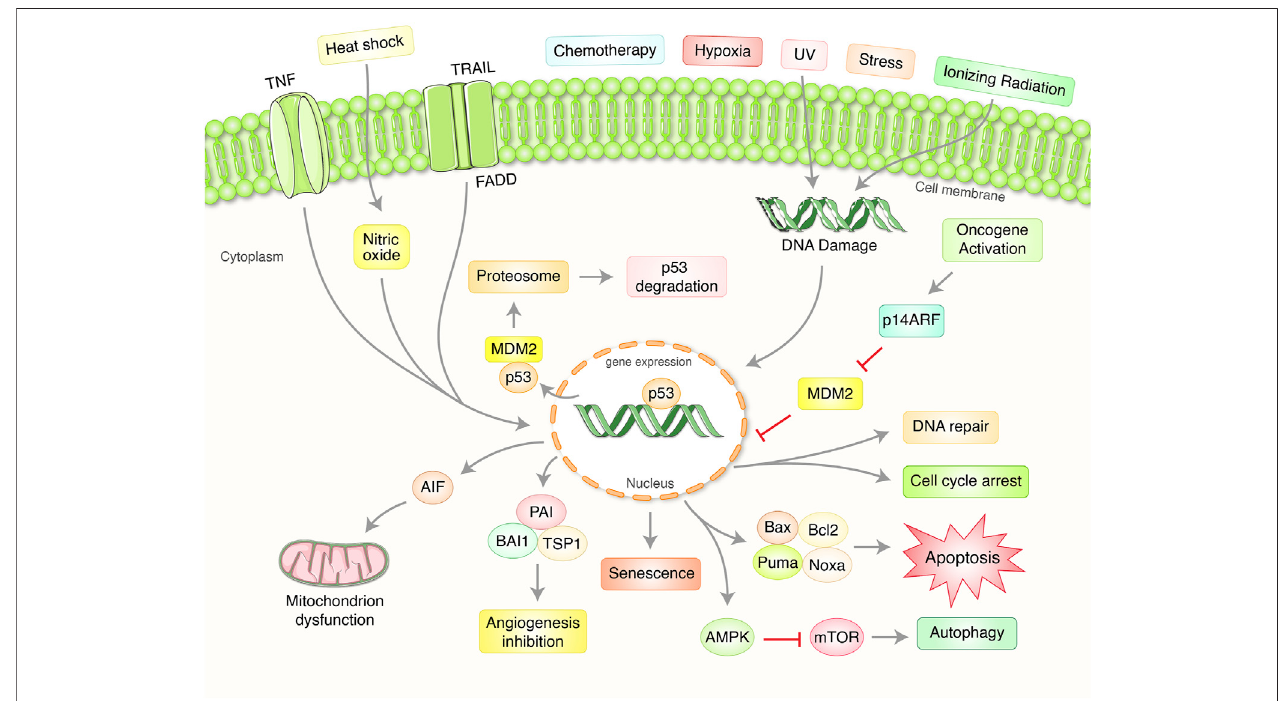
FIGURE 1 | Importance and regulation of tumor suppressor p53 pathway in the regulation of cancer. p53 protein plays an essential role in coordinating with a complex signaling network which regulate aberrant cell proliferation and growth. Normally, p53 has preserved at low steady-state levels with crucial regulation of two proteins,murinedoubleminute2(MDM2)aswellasMDMX.MDM2mediatesanattachmentofubiquitin(Ub)-mediatedproteasomaldegradation.Exposuretoultraviolet (UV) light and ionizing radiation activate several kinases and damaging stressors. Oncogenes overexpression has been found to stimulate the production of alternativereadingframe(ARF),p14ARF inhumanand p19ARF inmouse, which bindstoMDM2 aswellasstabilizesp53. Activation ofp53 protein hasbeentargeted to transactivate numerous gene expressions depending on the stressors and the cell type which signi fi cantly control either DNA repair, cell cycle arrest, senescence, apoptosis, mitochondrion regulation, autophagy, and angiogenesis.